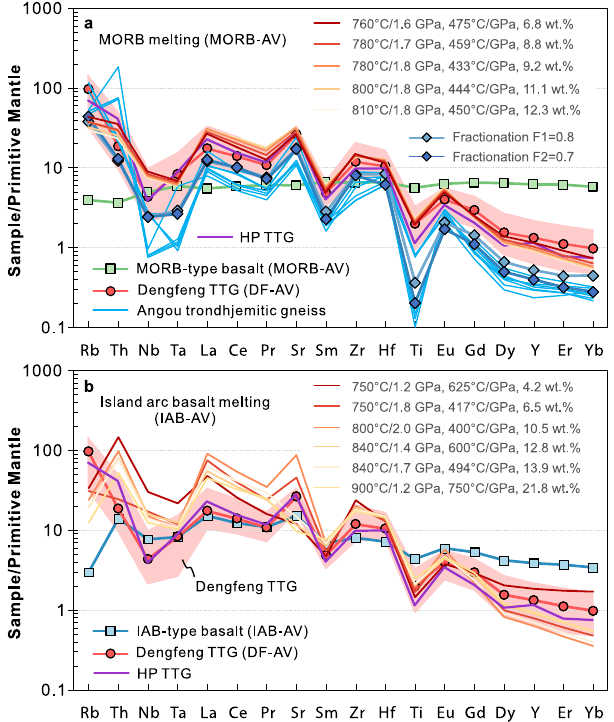
Fig.5|Traceelementmodeling.a UsingaverageMORB-typebasalt(MORB-AV)as the source rock. b Using average IAB-type basalt (IAB-AV) as the source rock. Full modeling results are presented in Supplementary Data 6, and selected repre- sentativeresultsareshownhere.Thecompositionsofevolvedmeltsresultingfrom removal of two assumed fractionating mineral assemblages (Supplementary Data 7) are shown. Primitive mantle normalized elemental compositions are from ref. 26. The average composition of high-pressure (HP) TTG is from ref.